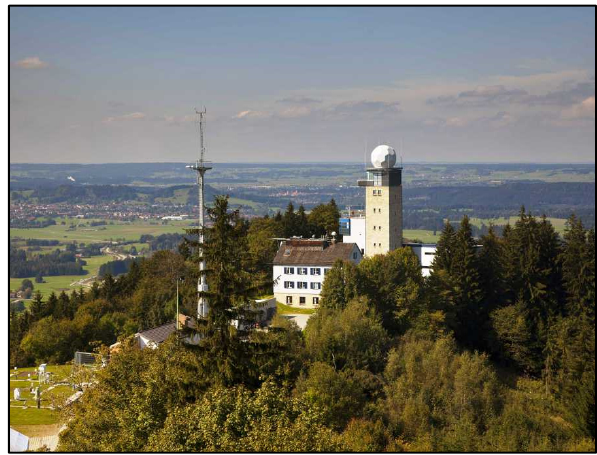
Site 6: Hohenpei ß enberg (rural, mountain) Figure